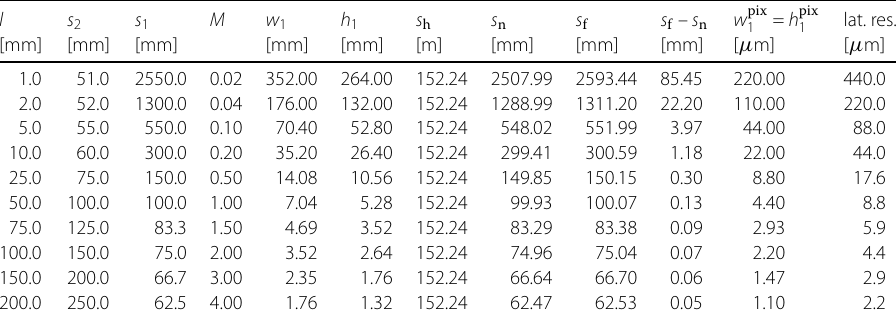
Table 3 Calculated performance parameters of a telemicroscope in dependence on the extension tube length (focal length: f = 50 mm; f-number: N = 2.8; sensor size: 7.04 mm × 5.28 mm; pixel size: